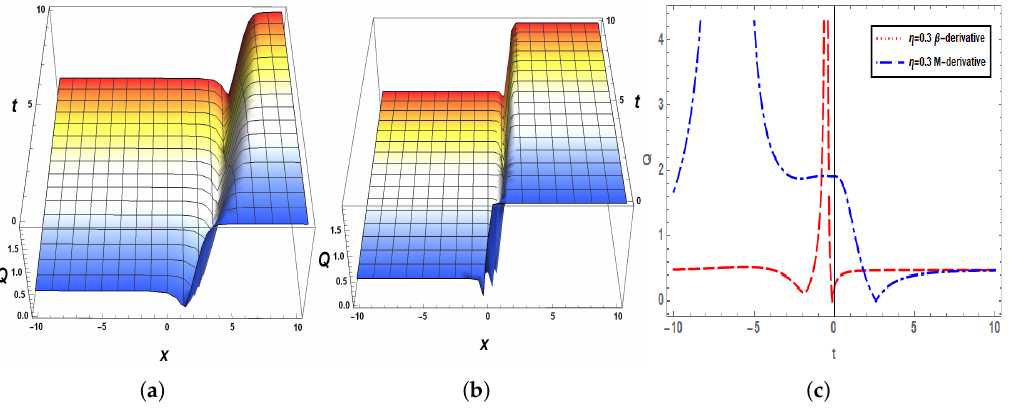
Figure 1. Depiction of 3 D and 2 D graphs of Q 4,1 ( x , t ) for µ = 0.1, γ = − 0.1, σ = 2, θ = 0.5, ϑ = 1, (cid:101) = 2, C = − 1, and λ = 1. Here, ( a , b ) display the 3 D graphs with Beta and M-truncated derivatives, while ( c ) represents the 2 D surface taking η = 0.3 at t = 1.